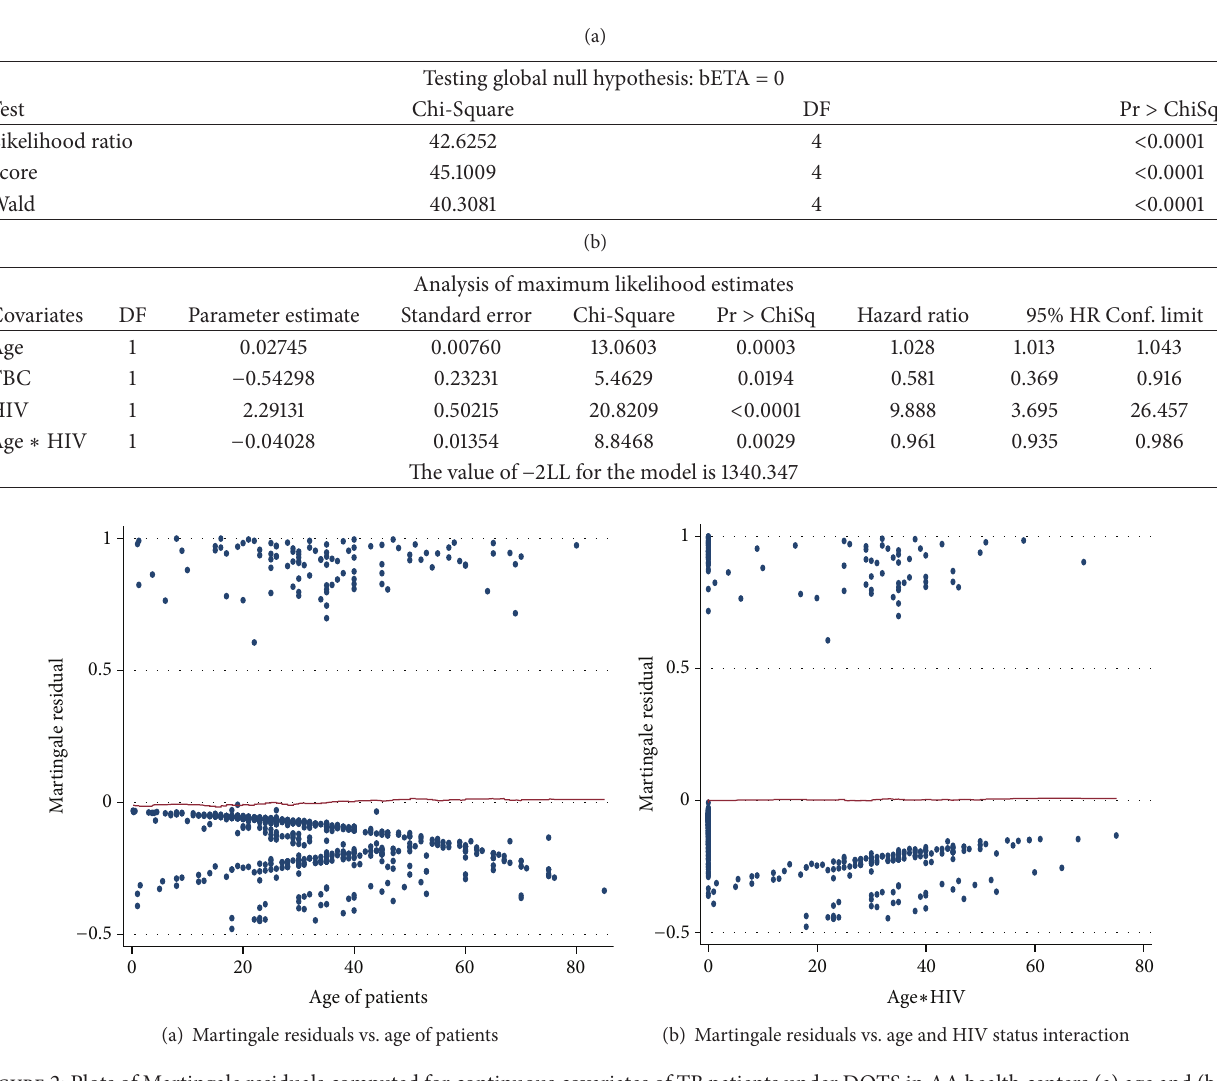
Table 7: Results of the multivariable proportional hazards Cox regression model containing the main and interaction effect.